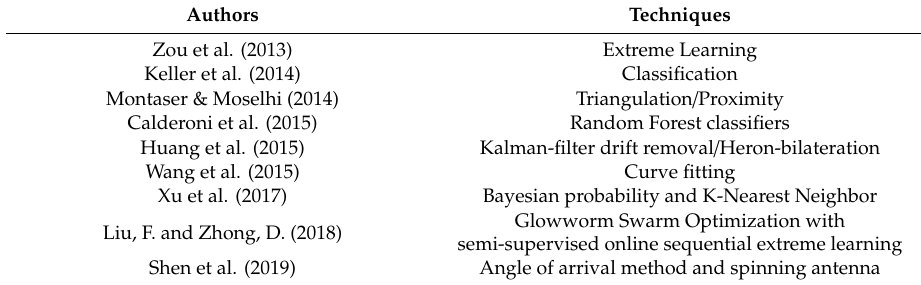
Table 2 summarized the Wi-Fi studies with the employed technique. Table 2. Overview of studies that utilize radio frequency identification (RFID) technology for indoor